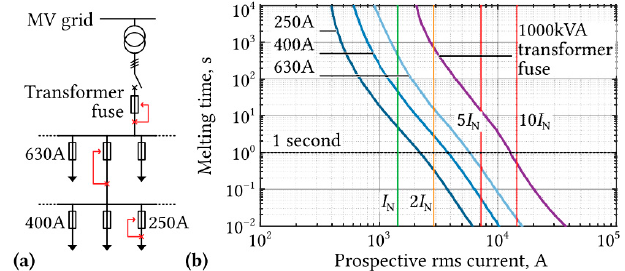
Figure 18. ( a ) Fuse and selectivity indications at various branching levels in a typical LV grid arrangement; ( b ) Melting time of LV fuses with different rated currents vs. current characteristics and a fuse for a 1000 kVA transformer in relation to its nominal current and its SST for a 1000 kVA transformer or LFT [77].